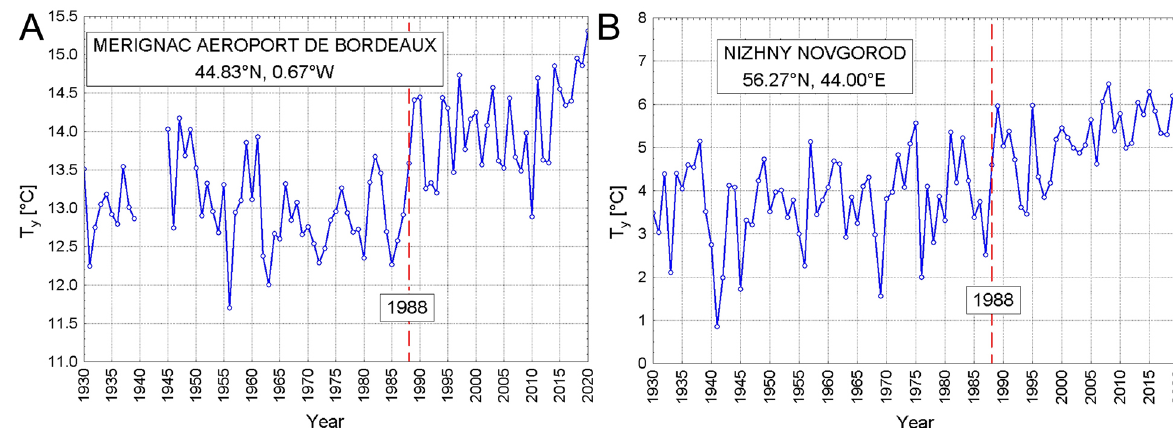
Fig. 3. The annual air temperature at Merignac Aeroport de Bordeaux (France, coast of the Bay of Biscay) (A) and at Nizhny Novgorode (the European part of the Russian Federation, around 350 km ENE of Moscow) (B) in 1930–2020. 1988 is marked with a vertical dashed line. The data in (A) are incomplete due to the Second World